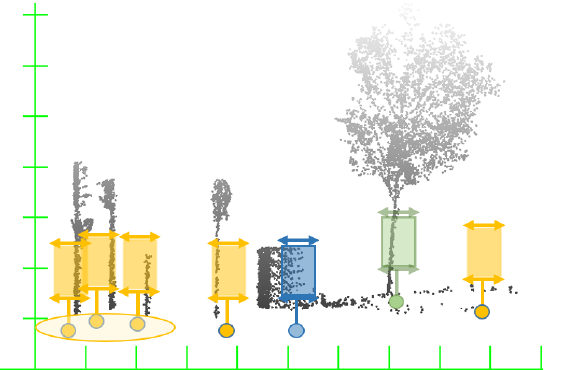
Figure 3. Seed selection based on location and semantics of map points, left three poles are considered as a group. Tick distance is 1